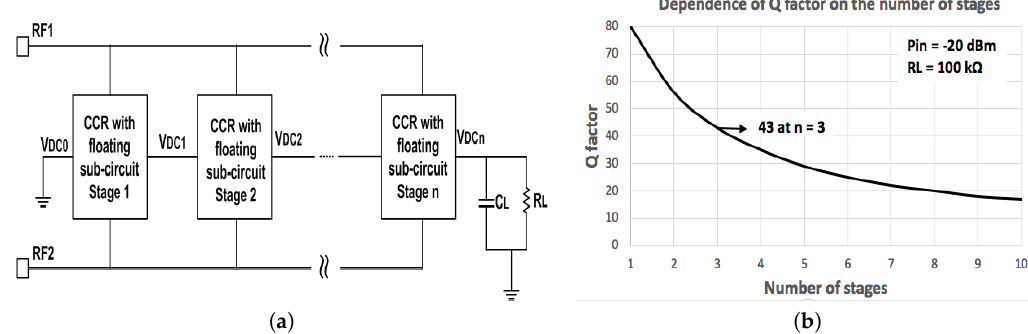
Figure 6. N-stage CCR with floating sub-circuits: ( a ) block diagram of the circuit, and ( b ) simulated dependence of Q factor on the number of rectifier